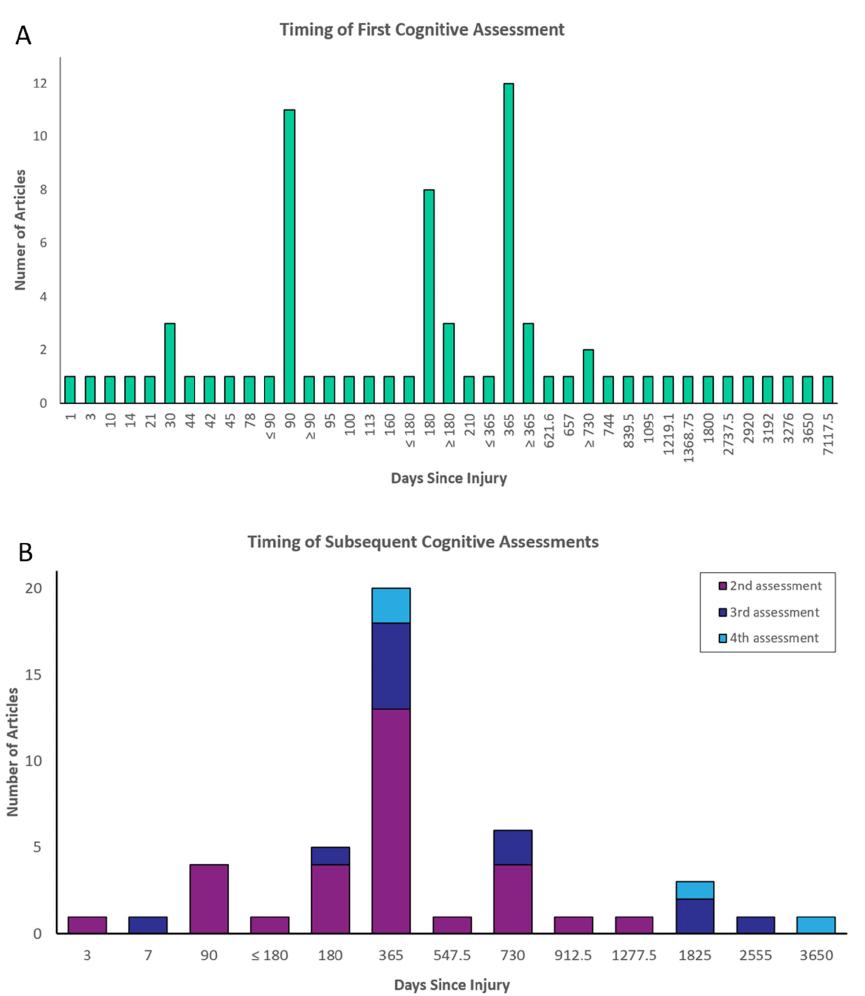
Figure 5. Number and interval of assessments relative to time since injury. ( A ). First cognitive assessment timepoint. ( B ). Timing of second, third and fourth cognitive assessment within a single study.